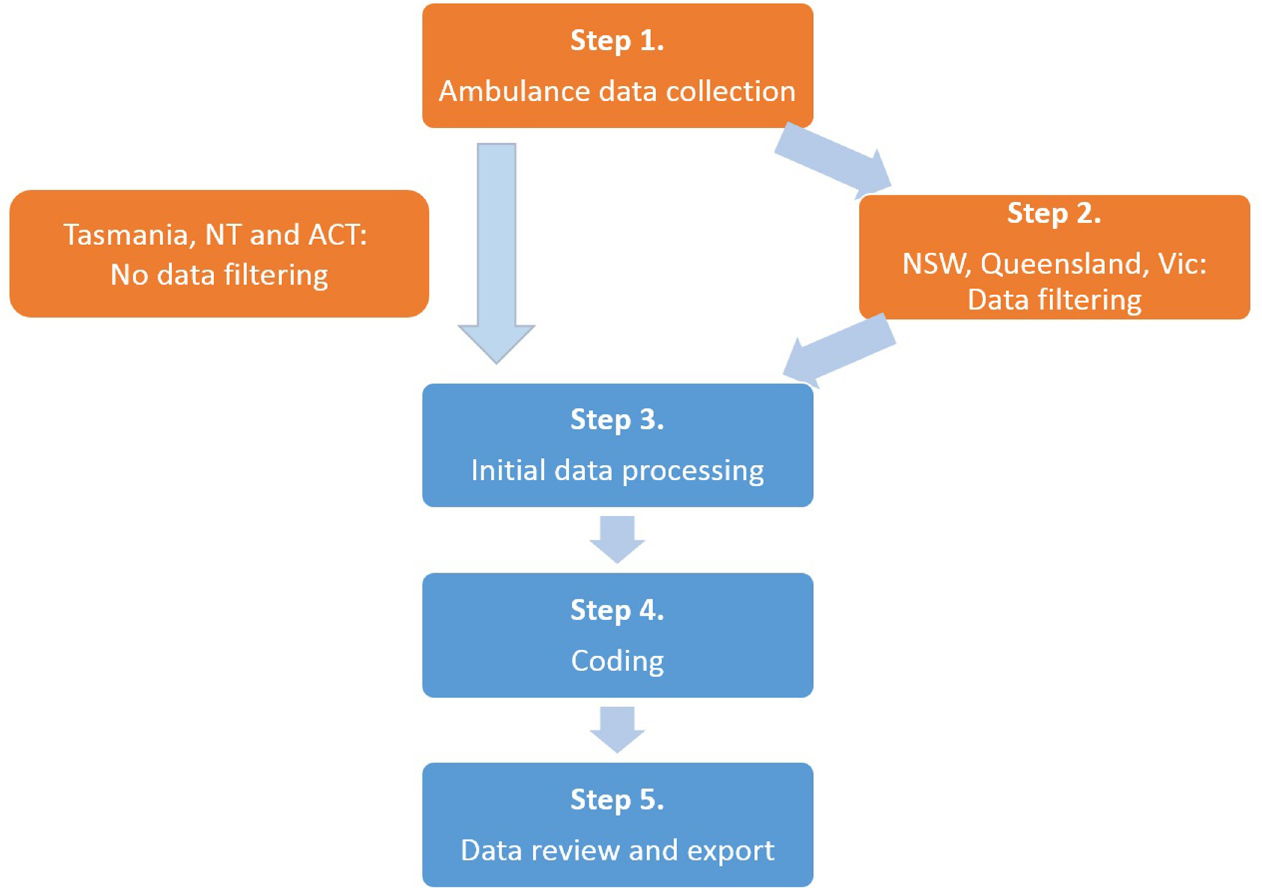
Fig 1. National Ambulance Surveillance System data collection and coding process. Processes in orange occur at the jurisdictional ambulance services, with processes in blue occurring at Turning Point.